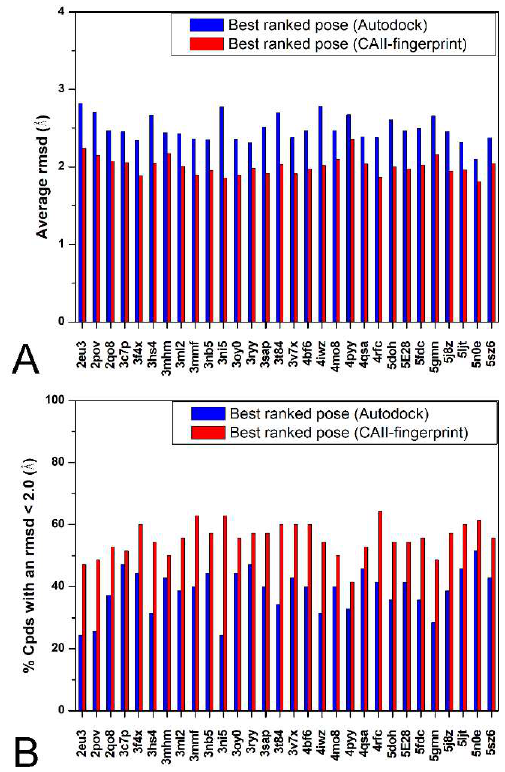
Figure 3. Comparison between the results obtained using the Autodock4 scoring function and the Tc-IFP for the external test set. For each CAII protein, the aRMSD ( A ) and the percentage of poses with a RMSD less than 2.0 Å ( B ) are reported for both the best-ranked pose using the Autodock4 scoring function (blue) and using the Tc-IFP function (red).